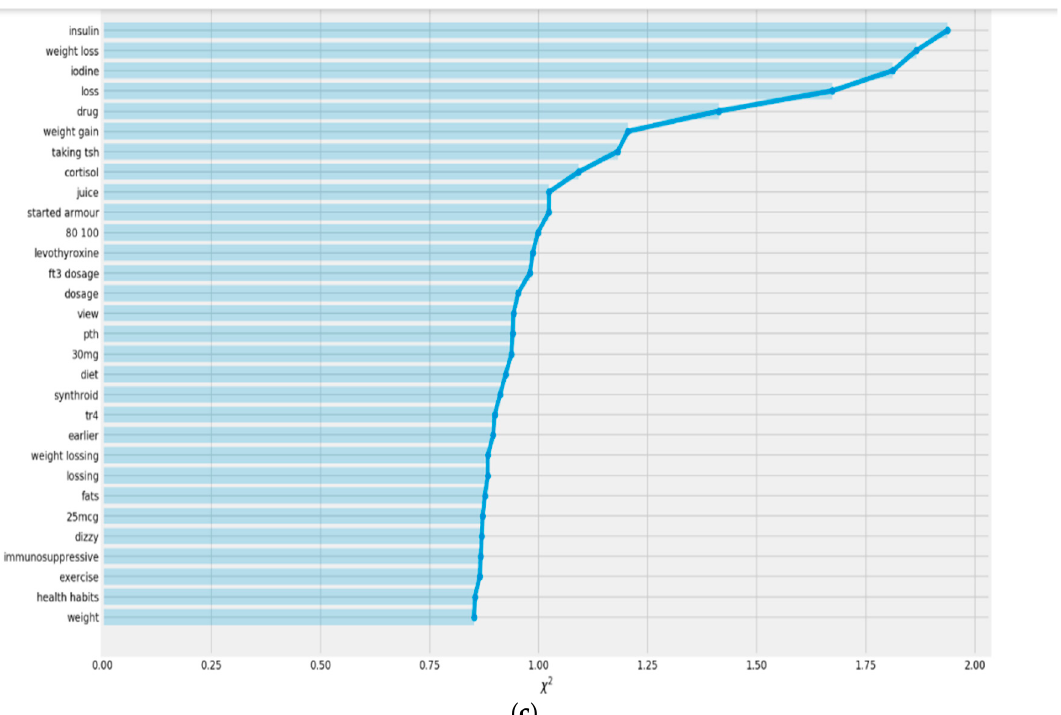
Figure 2. The chi-square test depicts the top 30 words: ( a ) DM, ( b ) thyroid and ( c )